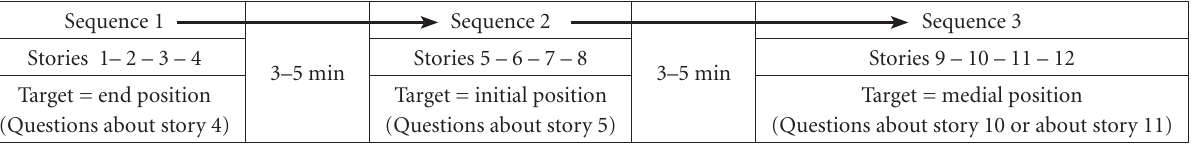
Figure 1. Scheme of stimulus presentation.